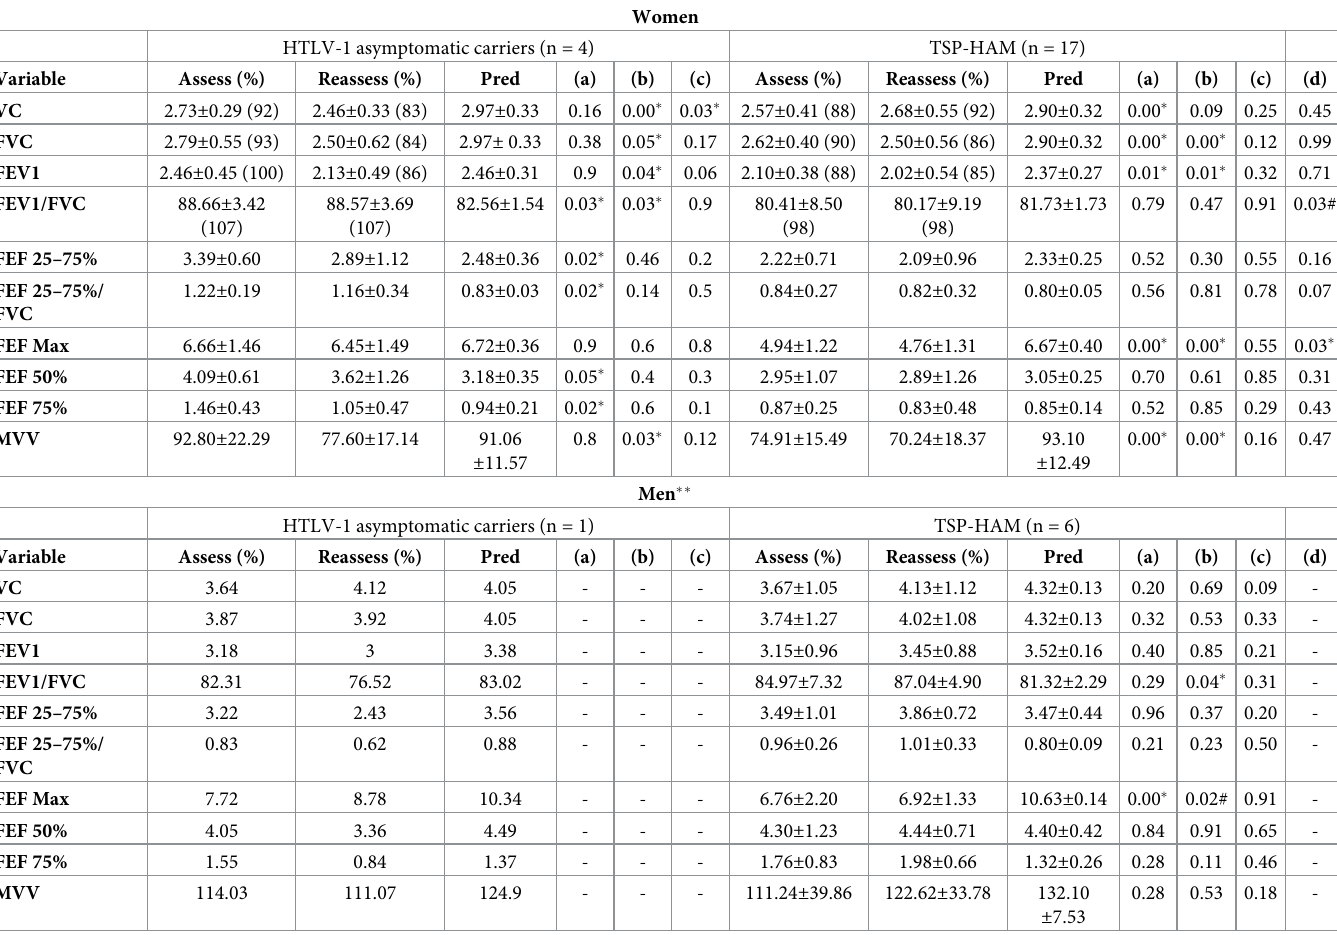
Table 5. Comparison of pulmonary lung function in individuals HTLV-1 asymptomatic carriers and TSP-HAM (2014–2019). Women HTLV-1 asymptomatic carriers (n =